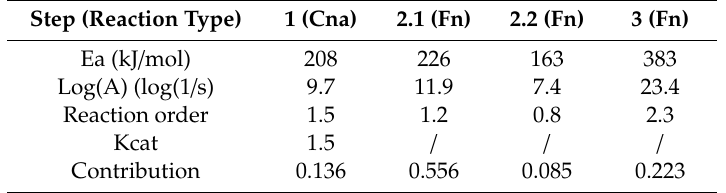
Table 2. Kinetic parameters used in the model for the thermal decomposition of PEEK under nitrogen.